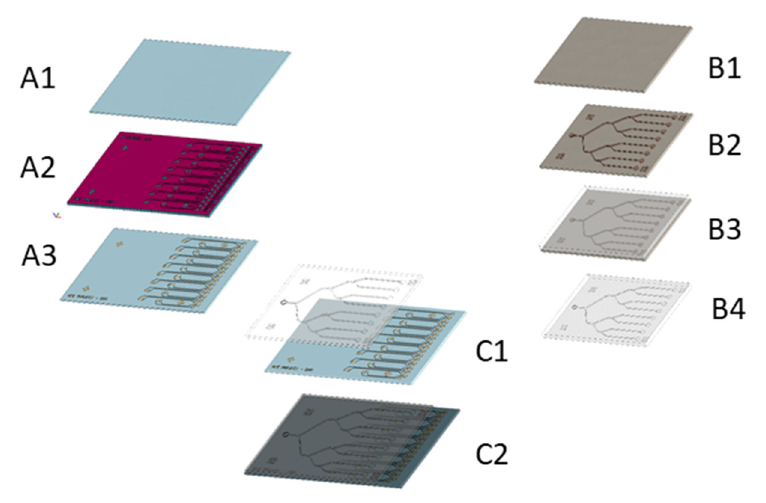
Figure 1. Fabrication process for the microfluidic device realization. ( A1 ). Glass substrate. ( A2 ). Li- thography step. ( A3 ). Metal sputtering (50 nm of TiW and 200 nm Au). ( B1 ). Silicon substrate. ( B2 ). Lithography with 2 µm SU8-2002 and 50 µm SU8-2050. ( B3 ). PDMS pouring on silicon mold. ( B4 ). PDMS peeling-off. ( C1 , C2 ). PDMS and glass substrate alignment and plasma bonding.